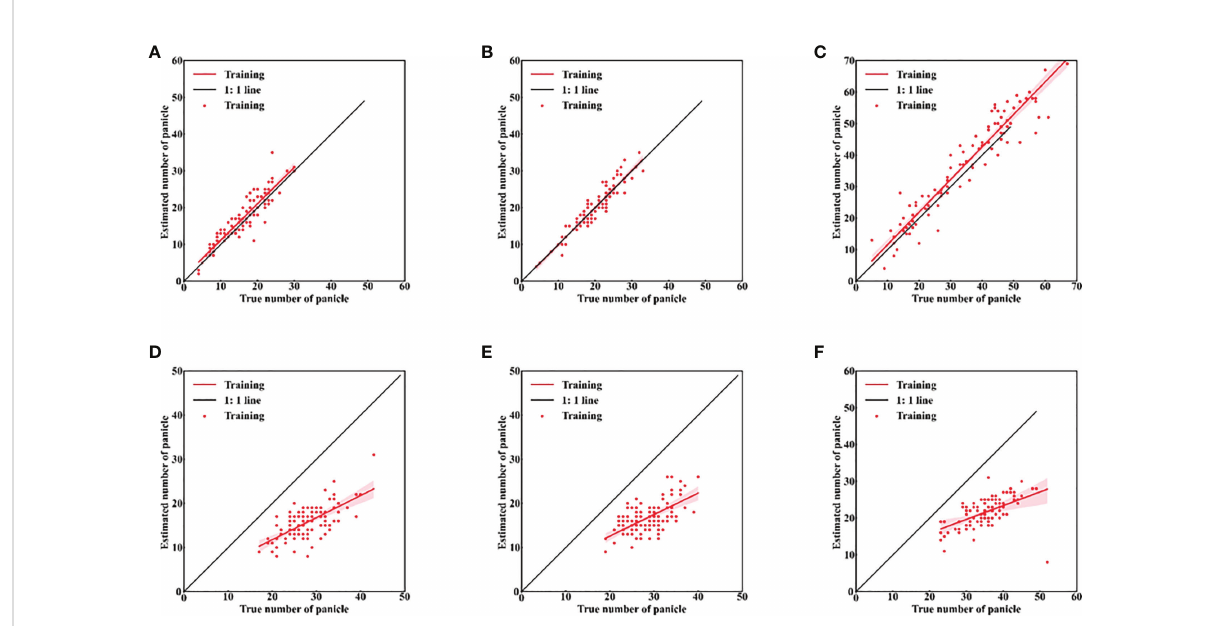
FIGURE 7 Accuracy of rice panicles identi fi cation in different data sets. (A – C) seven days after the full heading stage; (D – F) mature stage; (A, D) middle type; (B, E) spikes above leaves type; (C, F) leaves above spikes